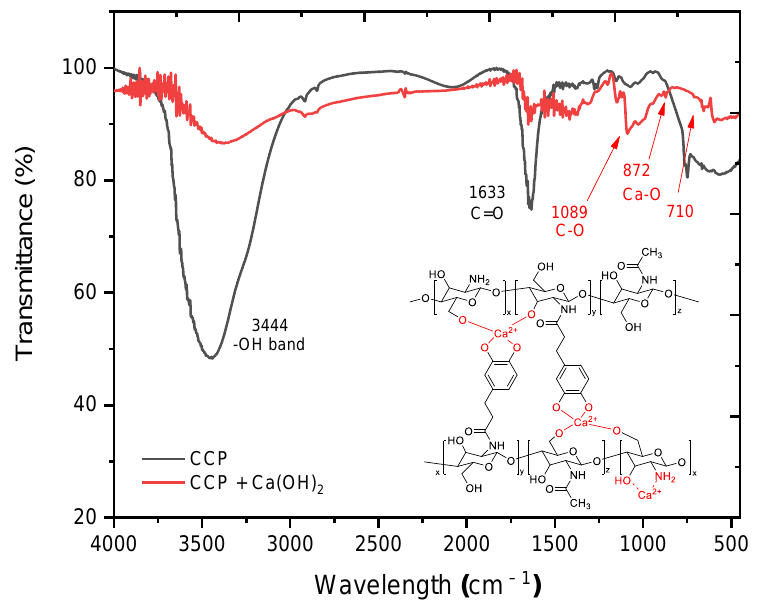
Figure 4. FT-IR spectra of CCP (black line) and CCP upon reacting with Ca(OH) 2 (red line). The expected structure of calcium–Cat-Chit was added in the spectra.